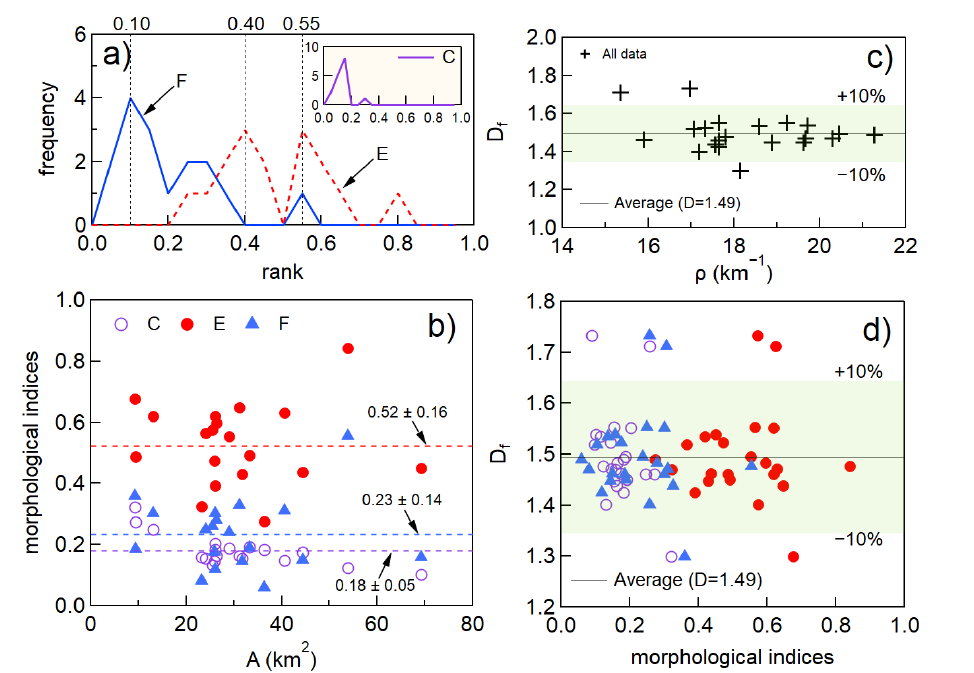
Figure 7. ( a ) Frequency distribution of morphological indices F , C , E . ( b ) Parameters F , C , E versus the area of each network A . ( c ) D f versus ρ and ( d ) D f versus F , C , E . The horizontal lines are global averages to data. The shadowed region (in green) is an arbitrary ± 10% scattering